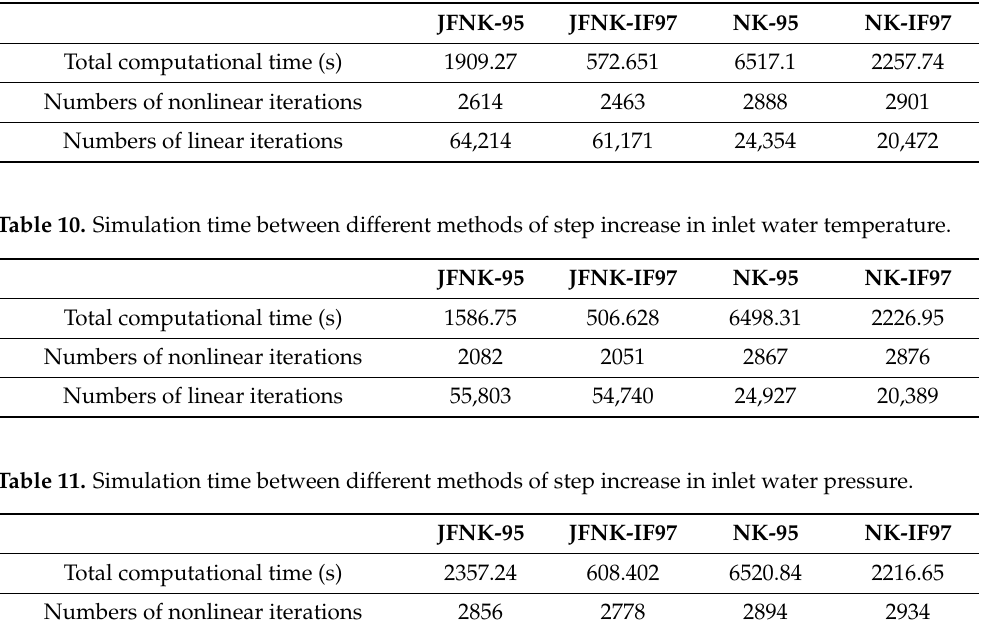
Table 9. Simulation time between different methods of step increase in inlet helium temperature.